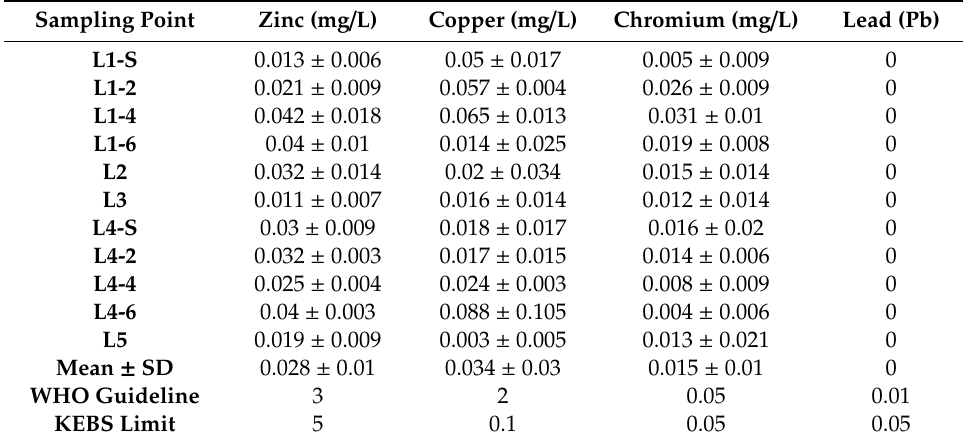
Table 12. Concentration of heavy metals in Rungiri quarry reservoir in August 2019.